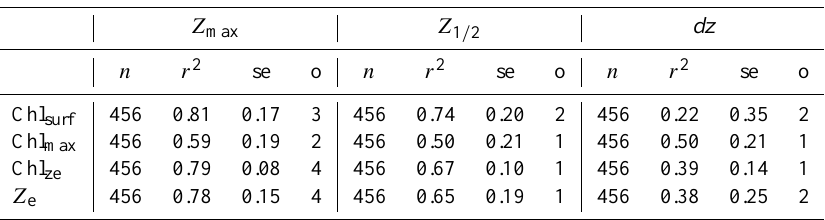
Fig. 4. Gaussian profiles: Scatterplot of log 10 -transformed Chl surf (mgm − 3 ) , Chl max (mgm − 3 ) , [Chl ze ] (mgm − 2 ) and Z e (m) as a function of log 10 -transformed depth-dependent shape parameters Z max (m), Z 1 / 2 (m) and dz (m). Colors refer to the different cruises/projects (see Table 2 for the abbreviations). The line corresponds to the polynomial fit within the data. The order of this fit as well as the coefficient of determination and the residuals standard error are indicated in Table 3. Table 3. Gaussian profiles: relationship between log 10 -transformed depth-dependent shape parameters and log 10 -transformed Chl- a and Z e . n , r 2 , se and o are the number of points, the coefficients of determination, the residuals standard error and the order of the polynomial fit, respectively. Z max Z 1 / 2